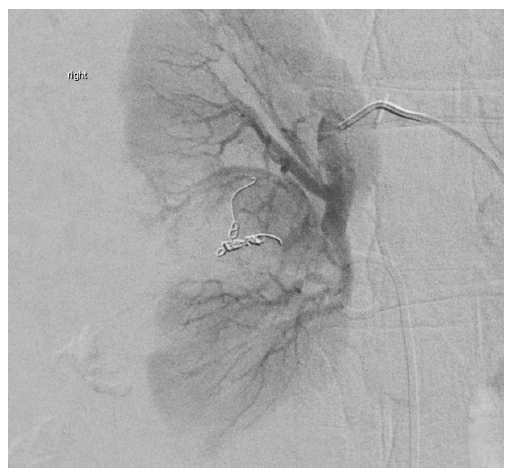
Figure 3: Successful arterial embolization demonstrating no signs of active contrast